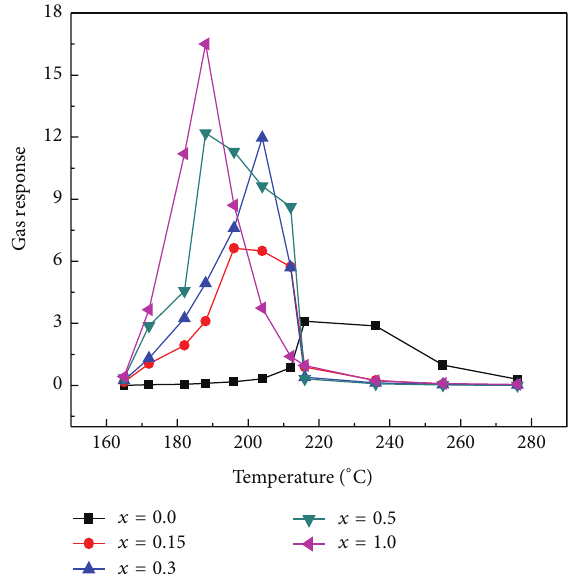
Figure 5: Arrhenius plots of electrical conductivity for La 1−𝑥 Nd 𝑥 FeO 3 (𝑥 = 0.0 – 1.0 ).